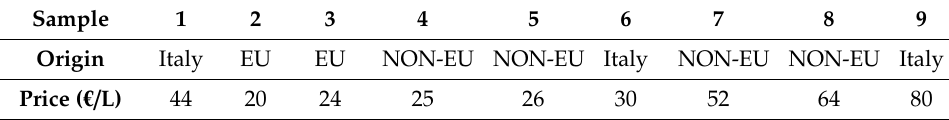
Table 1. Geographical provenience and price of the commercial hemp seed